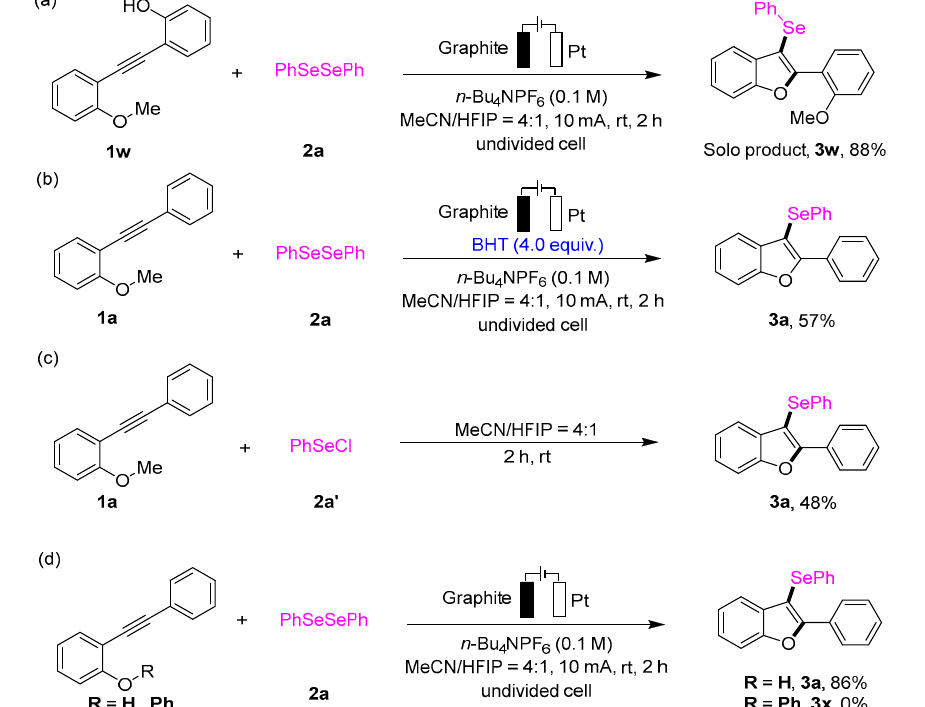
Scheme 5. Control experiments. ( a ) Intramolecular competition experiment. ( b ) Radical trapping experiment. ( c ) Reaction with PhSeCl. ( d ) Reactions with different substituents.